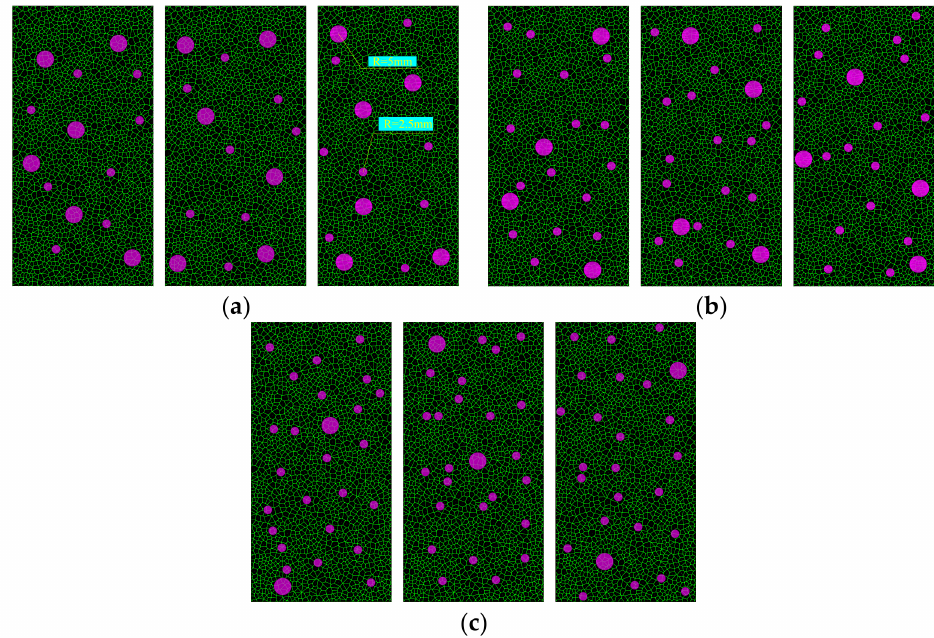
Figure 12. Proportion of 5 to 2.5 mm mineral circles under the same mineral ratio of 4.9%: ( a ) P1–P3: 6:2; ( b ) P4–P6: 4:4; ( c ) P7–P9: